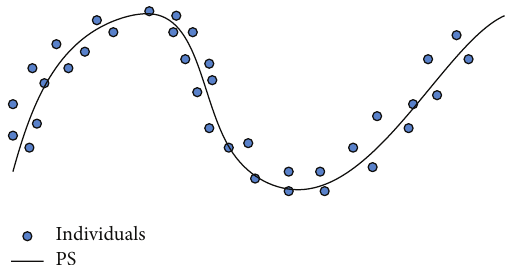
Figure 1: Individual solutions should be scattered around the PS in the decision space in a successful MOEA.